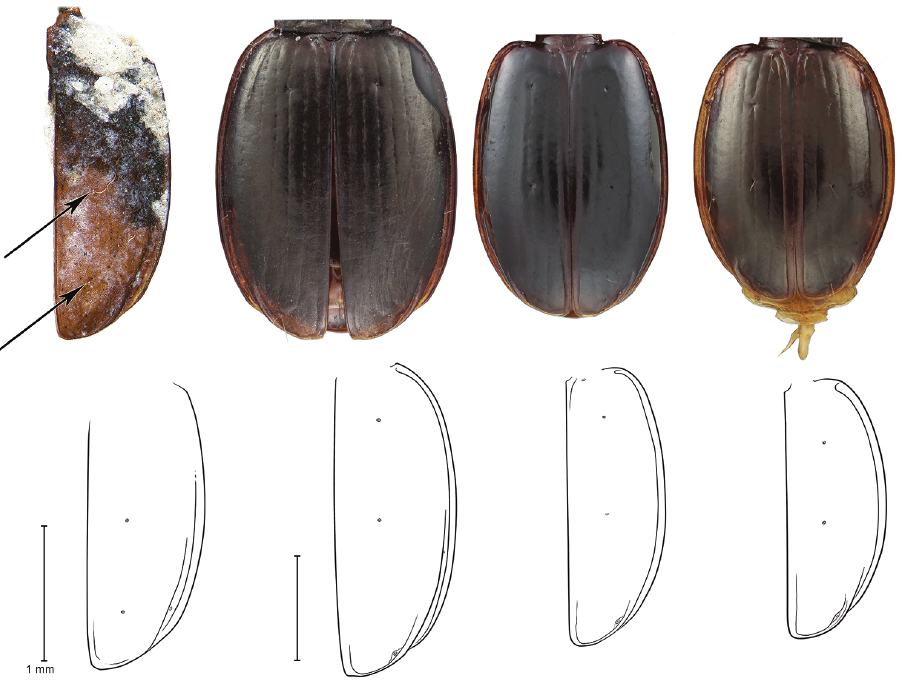
Figure 6. Fossil of right elytron of A. balli sp. n. and elytra of three species of Neaustral Trechisibus spp. with line drawings of each showing 3 rd interval setigerous pores and recurrent grooves of the